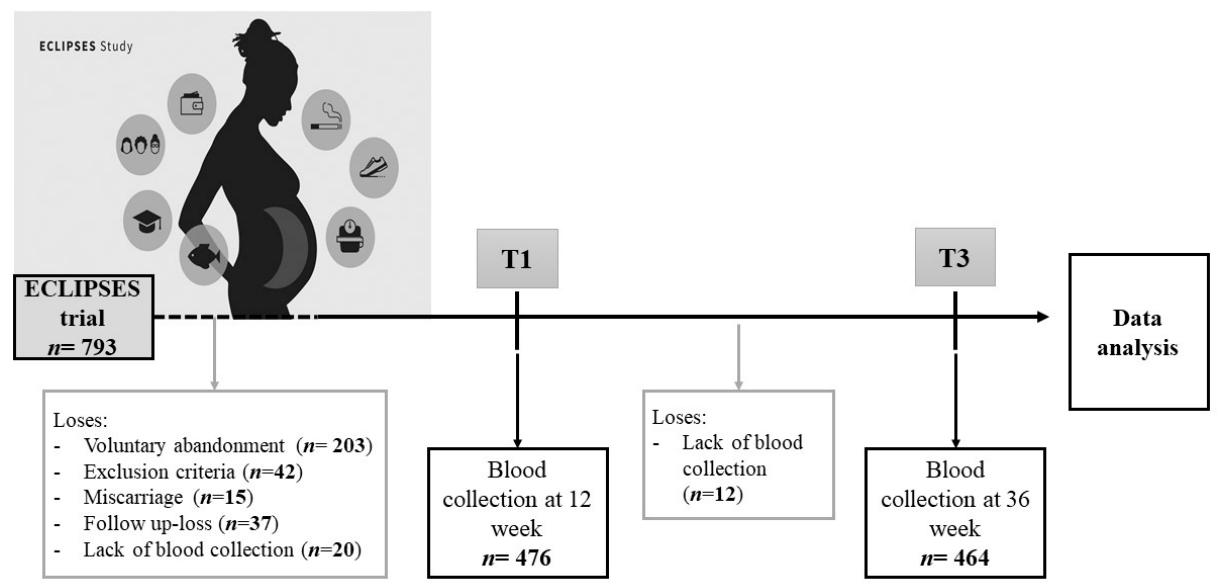
Figure 1. Flow chart of the study population.